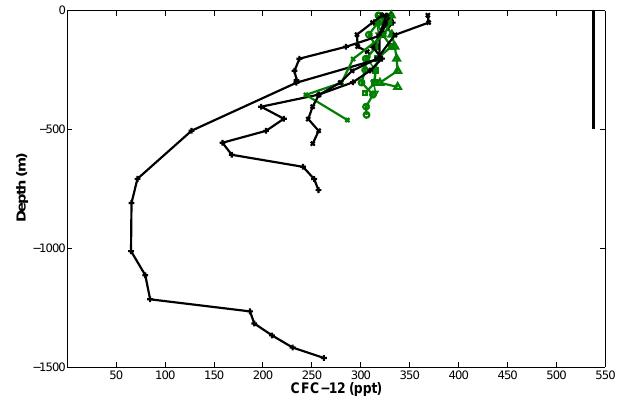
Fig. 7. CFC-12 [ppt] profiles from the northwestern Weddell Sea continental shelf ( < 500m; green profiles from black square in Fig. 2) and the continental slope (black profiles; “x” from north- ern stations – blue diamond in Fig. 2; “+” from western stations – blue square in Fig. 2) sampled during AW 06. The green symbols (circles, squares, and triangles) correspond to those in the noble gas vs. salinity diagram (Fig. 4). The solid line at 539 ppt depicts the at- mospheric (equilibrium) partial preassure relative to the year